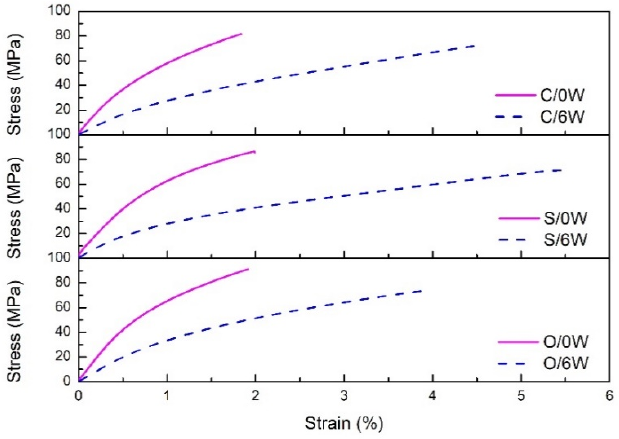
Figure 10. E ff ect of the water absorption on the stress-strain curves of di ff erent FFRPs at 70 ◦ C under 80%